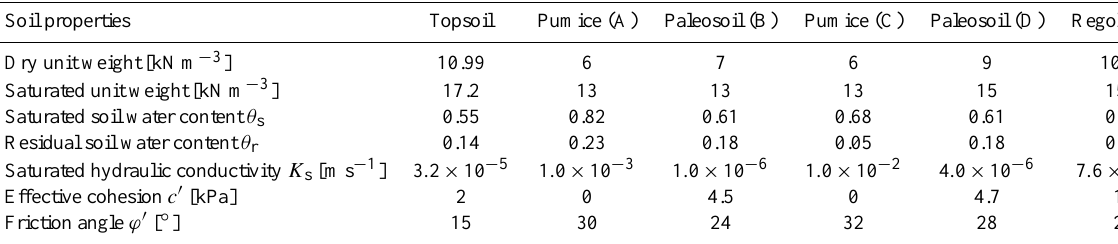
Table 3. Average values of pyroclastic soil properties. Soil properties